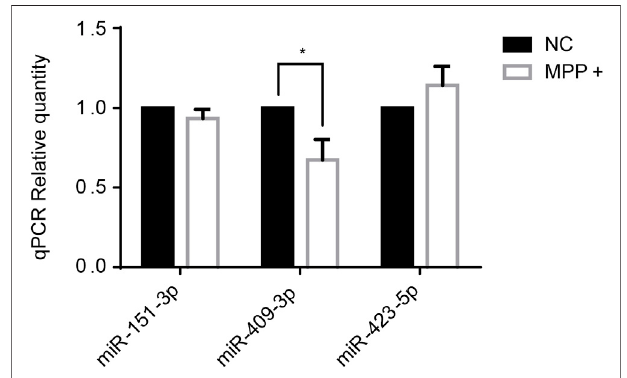
FIGURE 3 | Overexpression of miR-409-3p inhibits apoptosis in MPP + -induced SY5Y cells. (A) TUNEL staining of SH-SY5Y cells apoptosis in each group. Scale bar (cid:2) 50 μ m. (B) Histogram shows SH-SY5Y cells apoptosis ratio decrease in the miR-409-3p mimic group. Data were analyzed using Student t -test, ** p < 0.01.